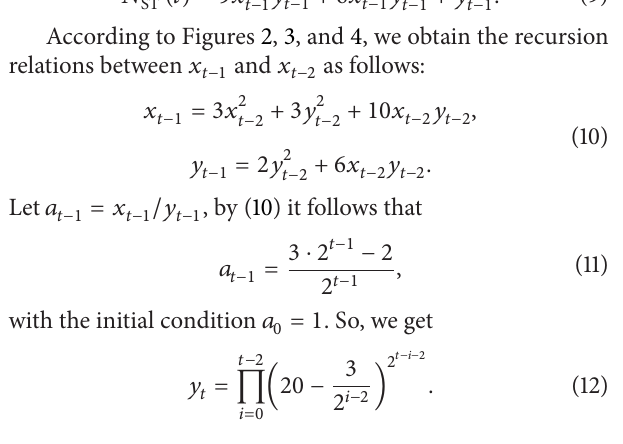
whole network is the average of all individual 𝐶 󸀠 𝑖 s. For this network, we can obtain the exact expression of the clustering coefficient 𝐶 𝑡 . By construction, for any given node 𝑢 having a degree 𝑘 , there are 𝐸 𝑢 = 3 ⋅ (𝑘 − 1)/2 links that actually exist among the neighbor nodes. So, one can see that there is a one-to-one corresponding relation between the coefficient 𝐶(𝑘) of the node and its degree 𝑘 : 𝐶(𝑘) = 3/𝑘 . This expression indicates that the local clustering scales as 𝐶(𝑘) ∼ 𝑘 −1